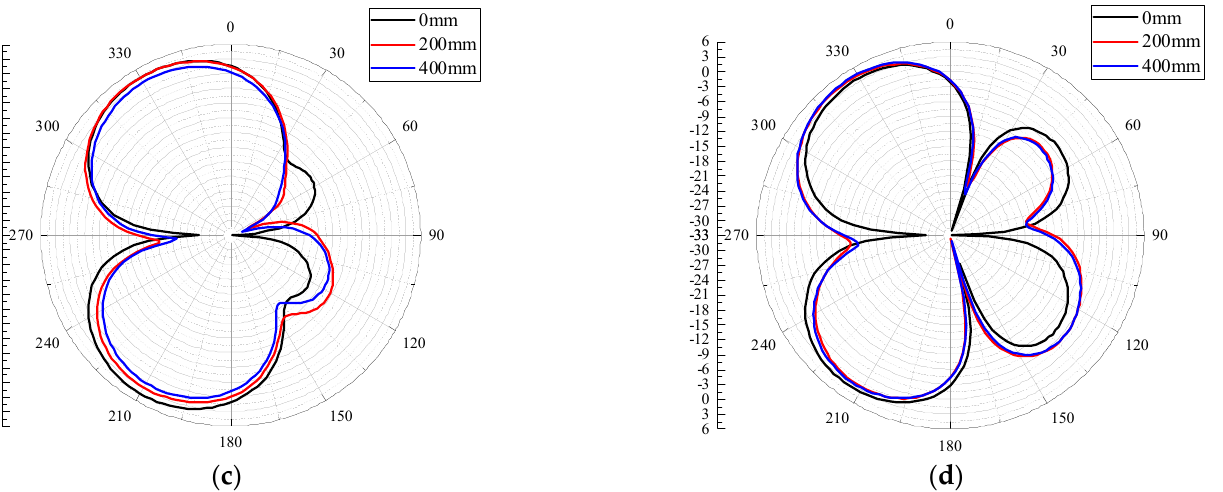
Figure 10. E-plane patterns at different frequencies: ( a ) 0.5 GHz; ( b ) 0.7 GHz; ( c ) 1 GHz; ( d ) 1.5 GHz.